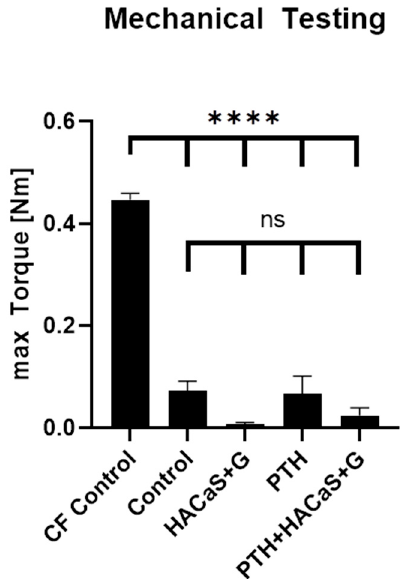
Figure 1. Mechanical testing. The max. torque of the contralateral intact femora (CF control) is significantly higher than all other groups, but there are no significant differences between the control and the treatment groups (PTH, HACaS+G and PTH+HACaS+G). **** = p < 0.0001, ns = not significant.